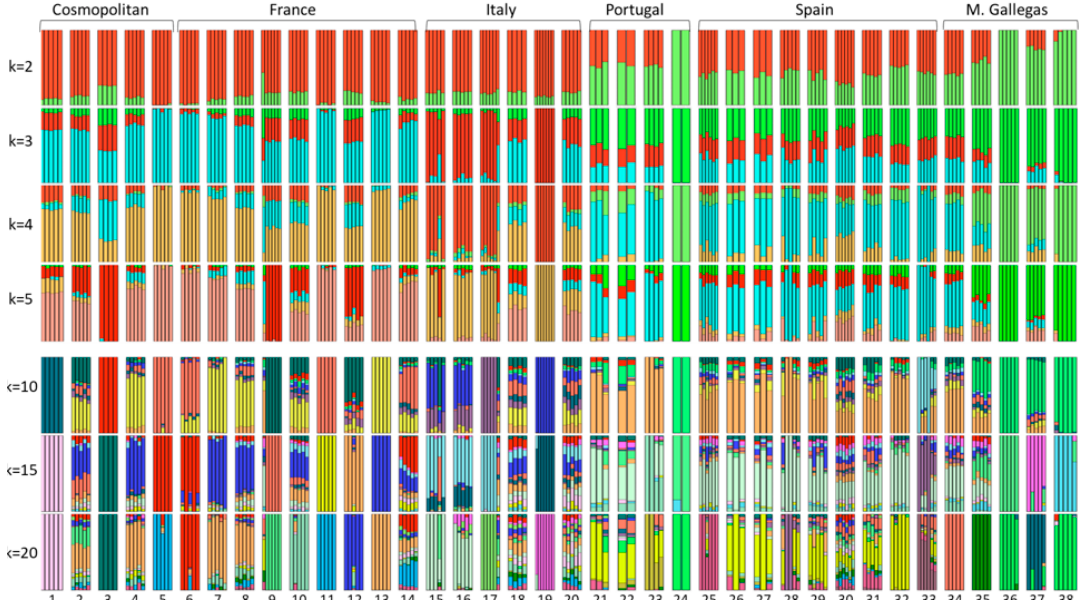
Figure 6. Admixture results among 38 European and the five Morenas Gallegas bovine breeds. Each animal is represented by a single vertical bar divided into K colors, where K is the number of assumed ancestral clusters, which is graphically represented for K = 2–5 and, 10, 15, 20. The equivalences of the breeds are the same as in Figure 5. Briefly: 24: Mirandesa; 34: Cachena; 35: Caldelá; 36: Frieiresa; 37: Limiá; 38: Vianesa.